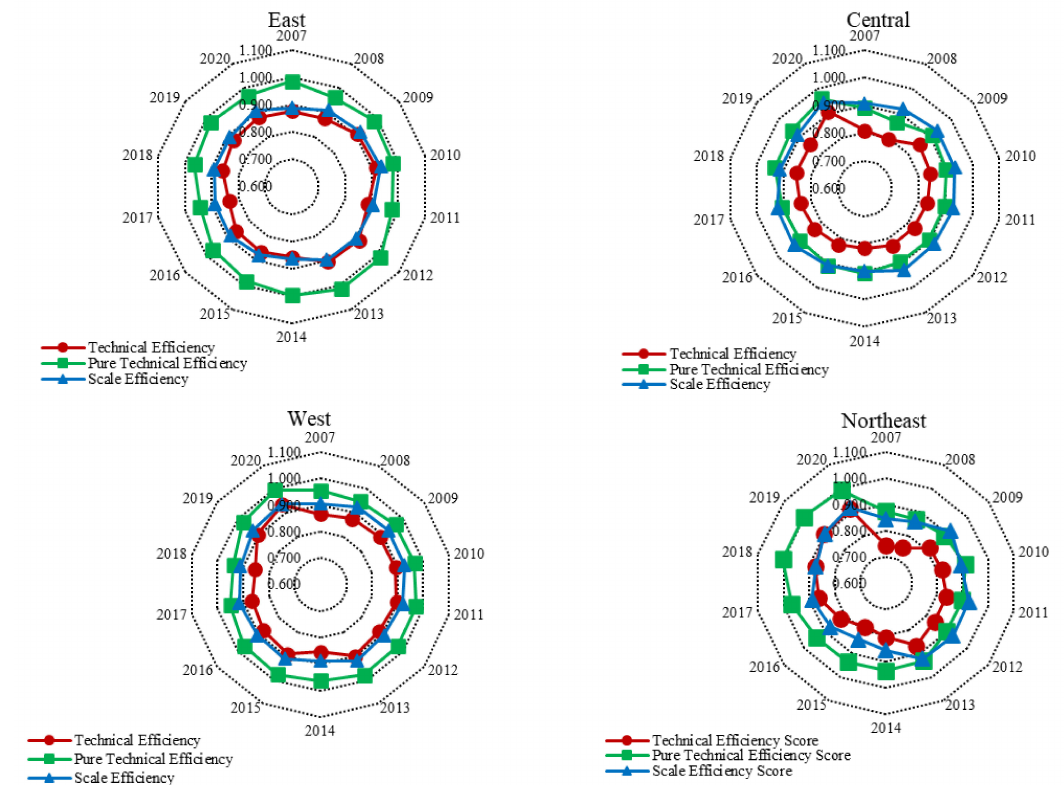
Figure 4. EWP of four regions in China from 2007 to